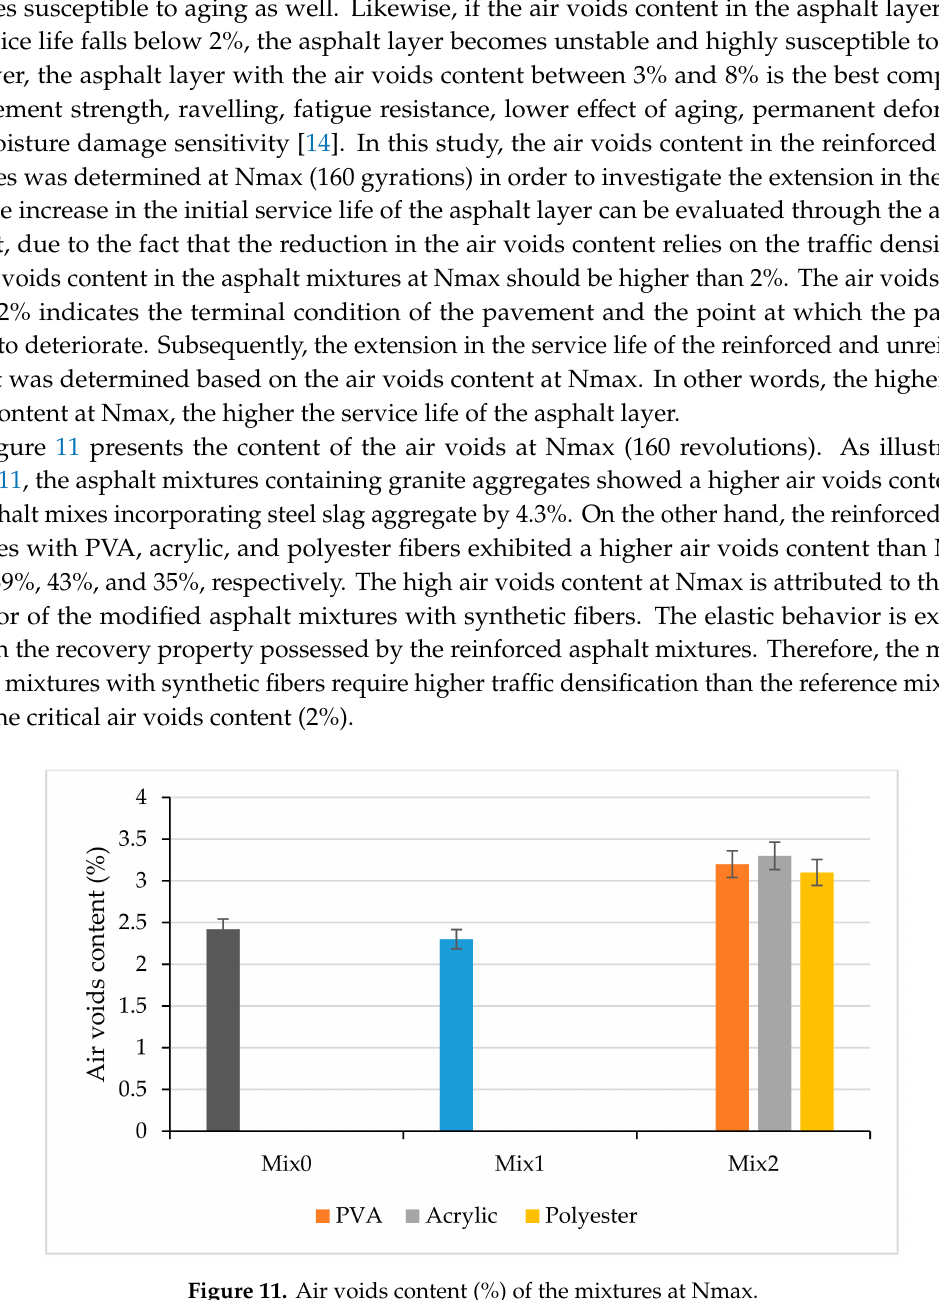
Figure 11. Air voids content (%) of the mixtures at